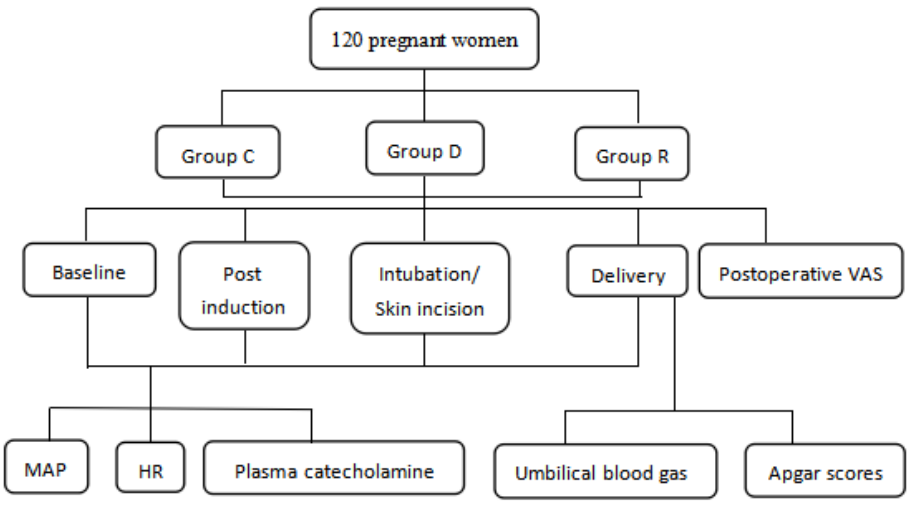
Fig. 1. Flow diagram of patient enrollment and data